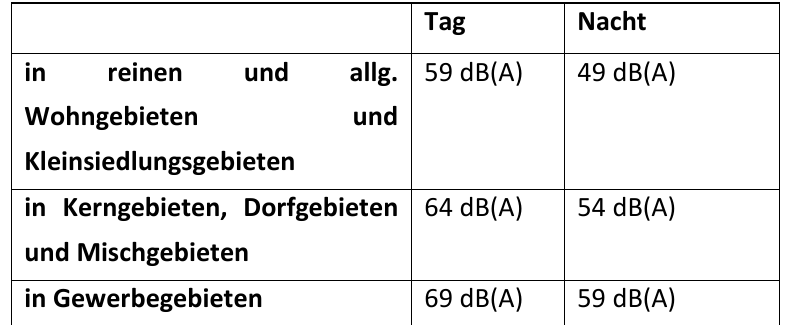
Table 1: Traffic noise limits for new road construction according to the Regulation on Pollution Values Tag Nacht in reinen und allg.